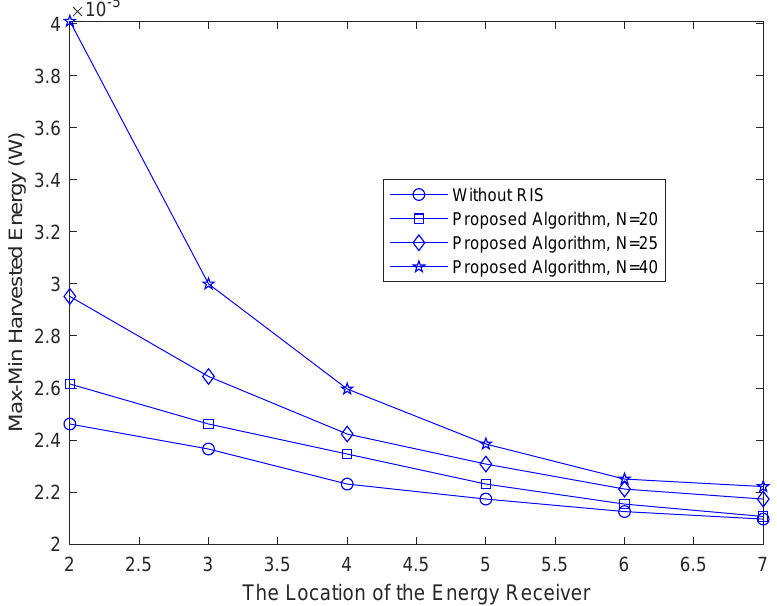
Figure 5. Max-min harvested energy by an energy receiver versus receiver location.